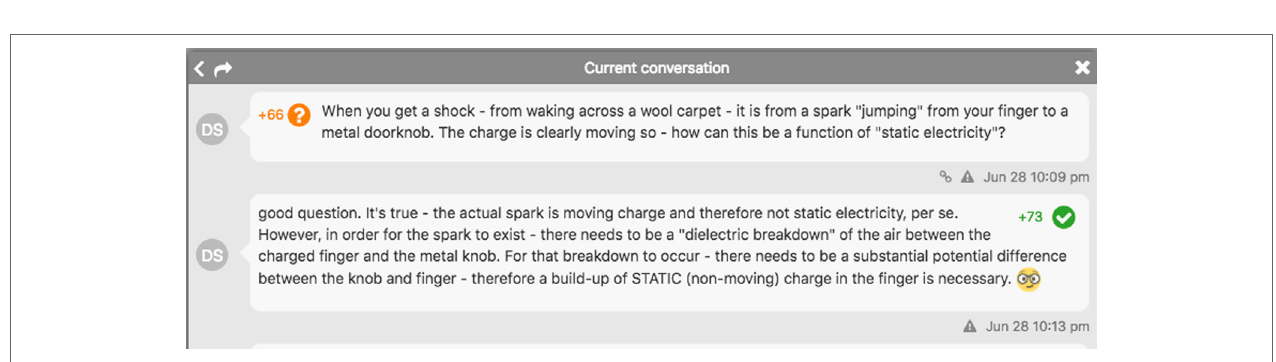
FigUre 5 | Upvoting of explanations in Perusall (note: the depicted individuals provided written informed consent for the publication of their identifiable images).